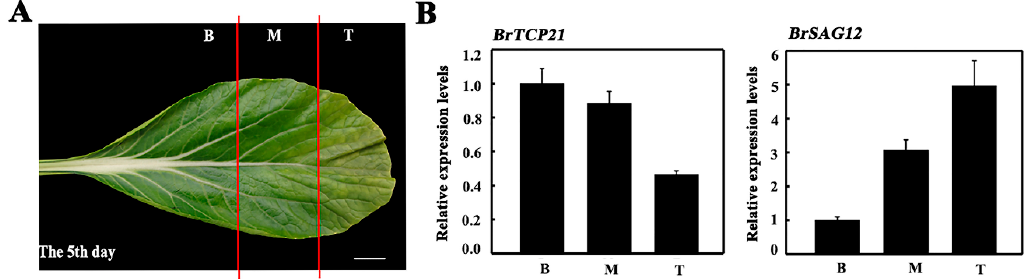
Figure 3. Localized expression of BrTCP21 in a senescing leaf. ( A ) The third leaves from the bottom of cabbage plants on the 5th days was detached and separated into three parts as illustrated. B basal part, M middle part, T tip part. Bar = 2 cm . ( B ) Expression of BrTCP21 and BrSAG12 . Data are the mean ± S.E. of three biological replicates.